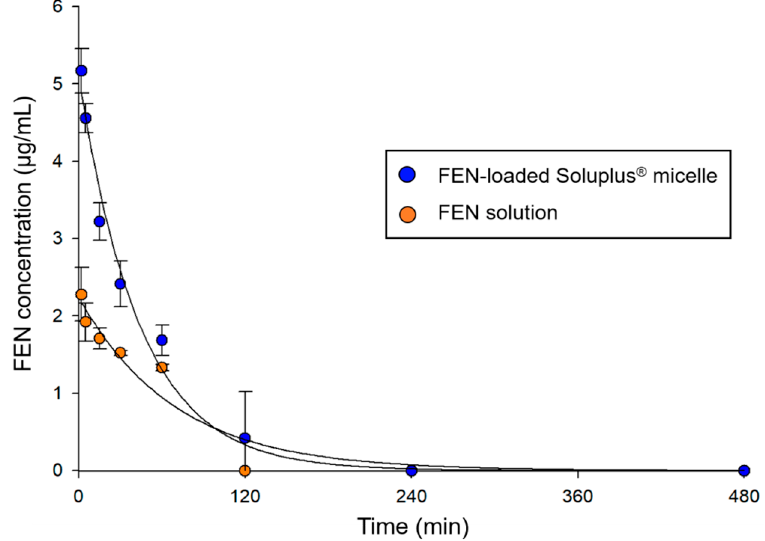
Figure 7. Plasma fenbendazole (FEN) concentration vs. time profile after intravenous injection of FEN-loaded Soluplus ® micelles and FEN dissolved in 25% Cremophor EL ® /EtOH solution. Table 2. Pharmacokinetic parameters of fenbendazole (FEN) after intravenous injection of FEN- loaded Soluplus ® micelles and FEN dissolved in 25% Cremophor EL ® /EtOH solution.